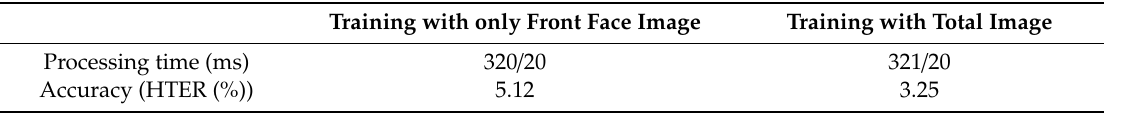
Table 7. Spoofing detection processing times and classification accuracies for a single image based on distance and angle variations (using only CPU / using GPU